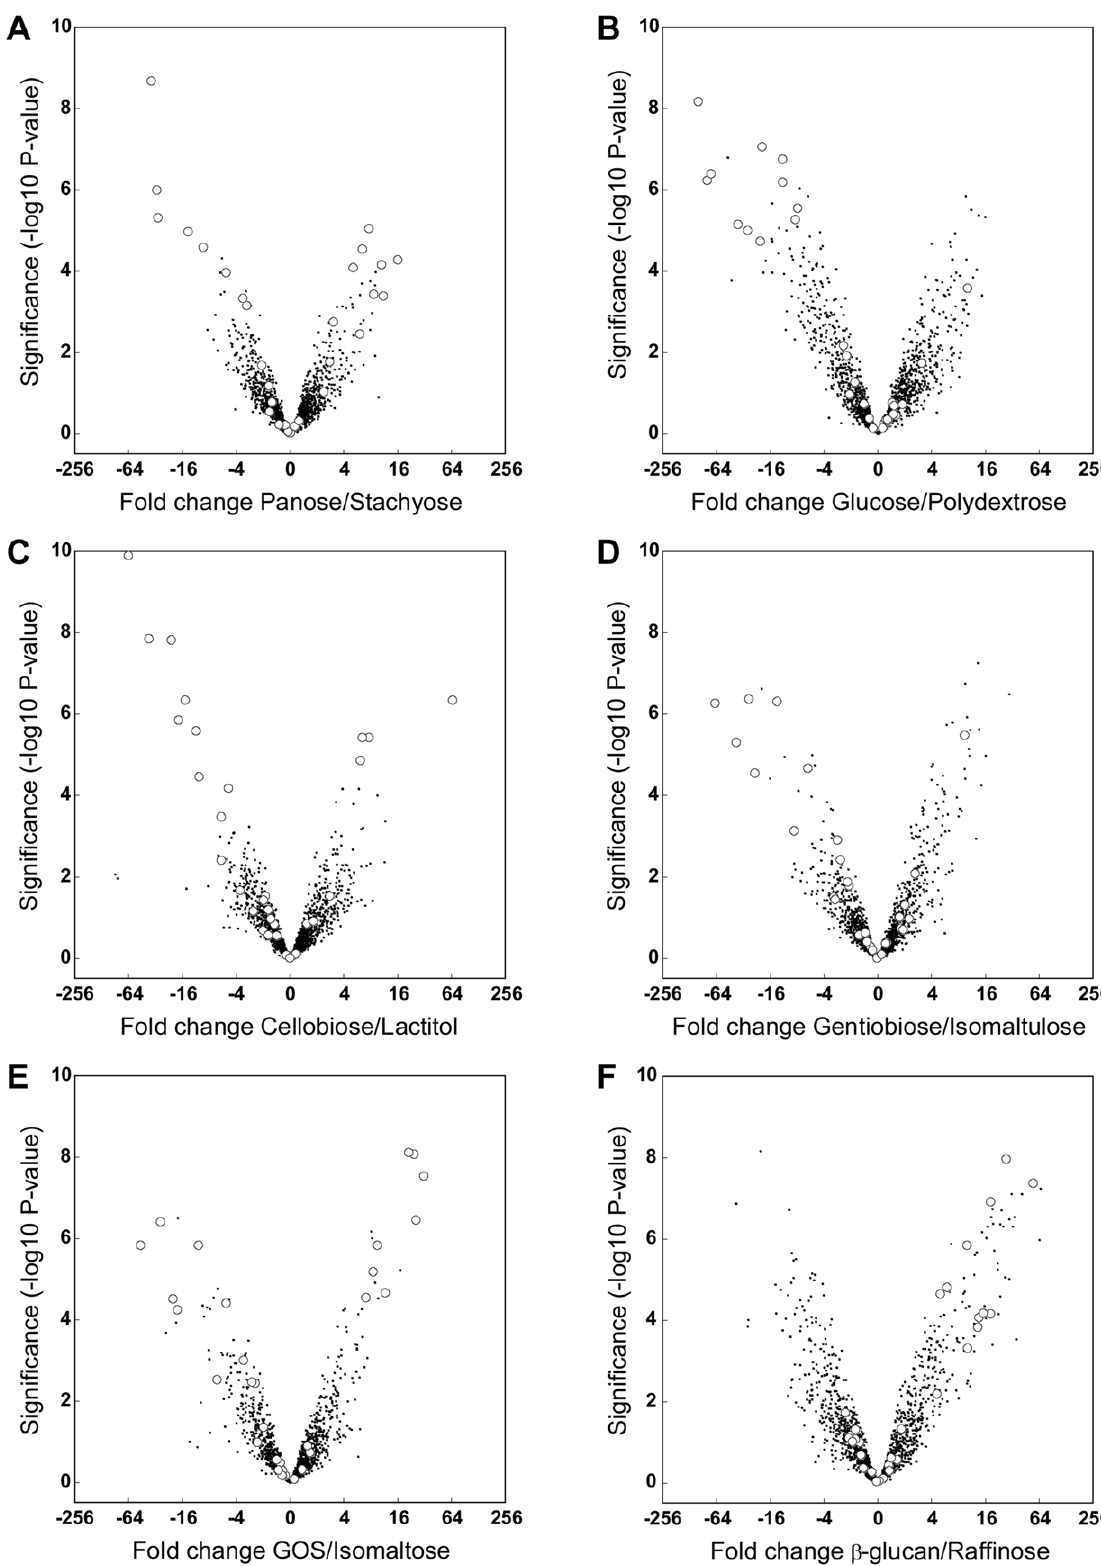
Figure 1. Representative volcano plots of the oligosaccharide-induced differential global transcriptome within L.acidophilus NCFM. All genes are shown as black dots ( ? ) and all statistically significant upregulated genes involved with oligosaccharide metabolism (Table 1) are depicted as white circles ( # ).